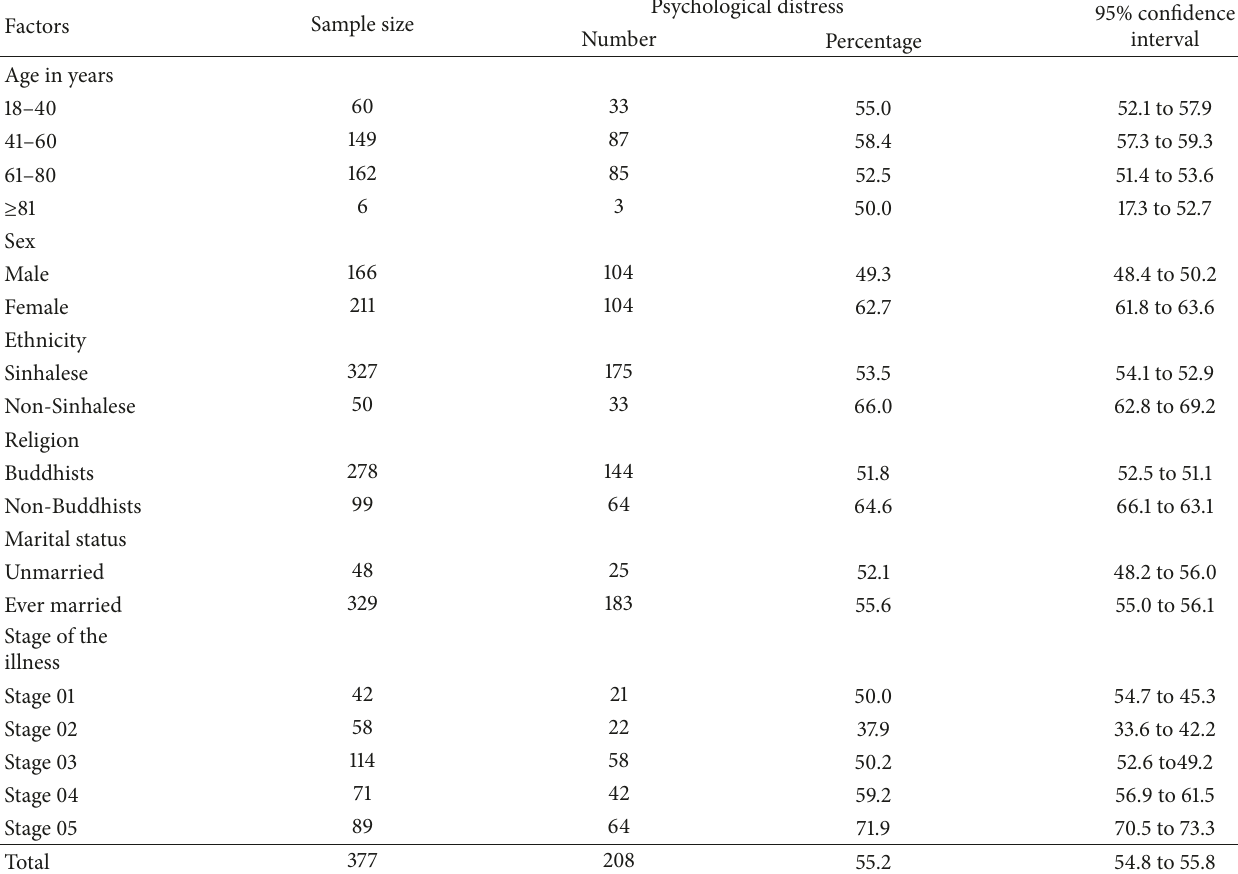
Table 1: Percentage of psychological distress according to selected